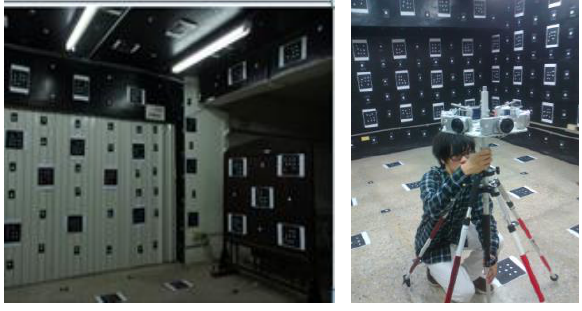
Figure 7. Indoor calibration field